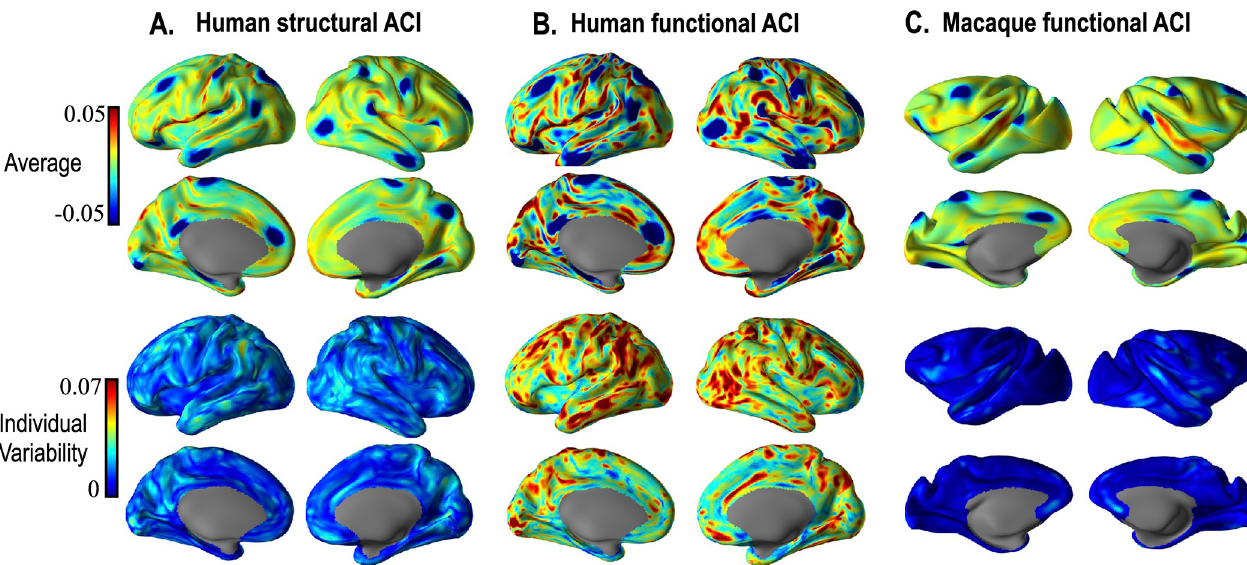
Fig 7. Cortical surface area changes in macaques and humans after structural registration and functional (combined structural and functional features) registration. The left/right hemisphere of human and macaque subjects were registered to the left/right hemisphere of the human template and the macaque template, respectively. The first two top rows are the average of ACI over 13 individuals. The bottom two rows are the standard deviation of ACI. The blue color in the average figure indicates where the area after registration to the group template was less than that of the group template.